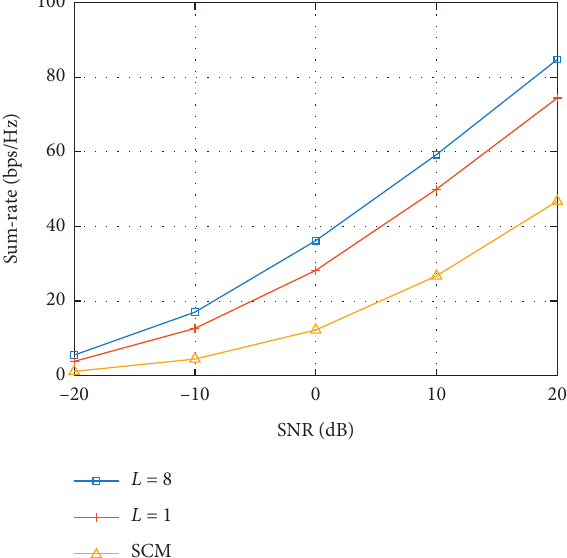
Figure 9: Sum-rate versus the number of RF chains in different channel environments ( v � 6 , h � 6 ) .